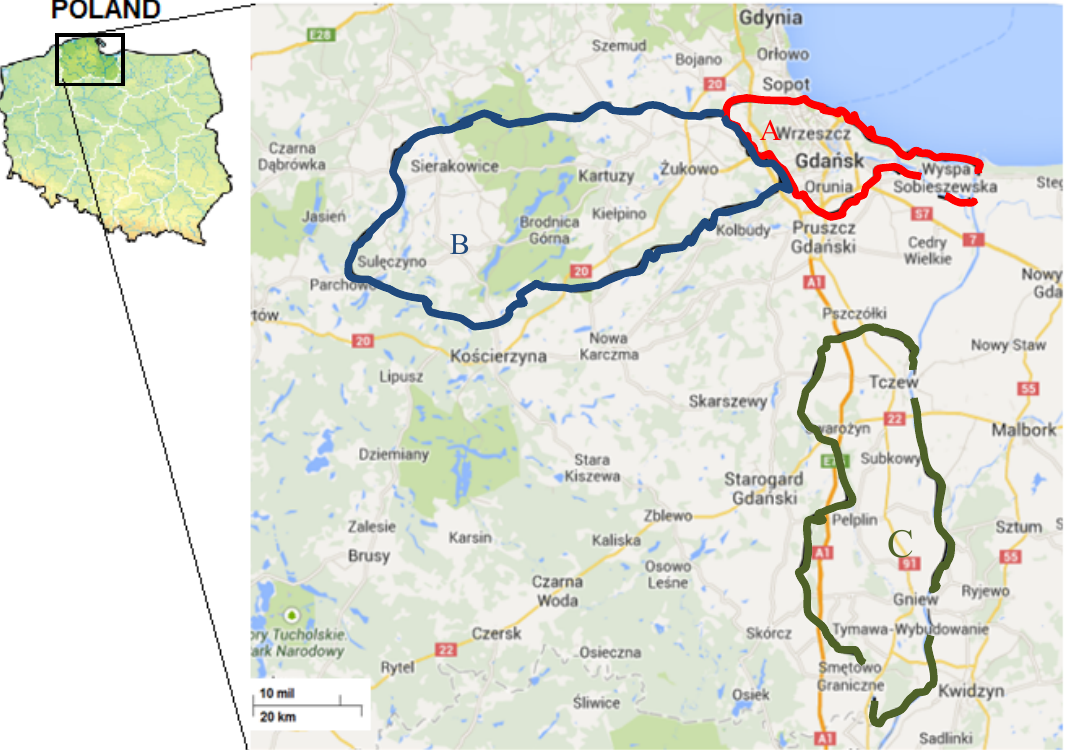
Figure 3. Location of the sample collection area in the northern part of Poland (Pomerania): A (Gdansk)—samples 1–7; B (Kartuzy)—samples 8–13; C (Tczew)—samples